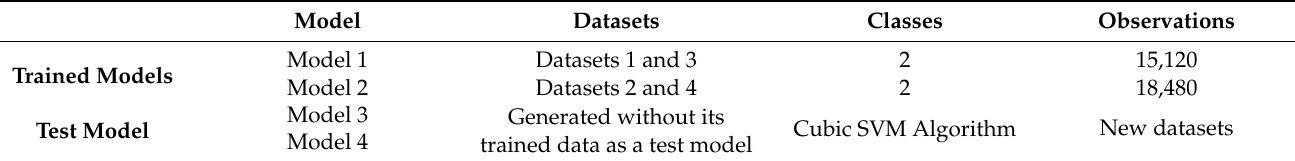
Table 12. Machine learning